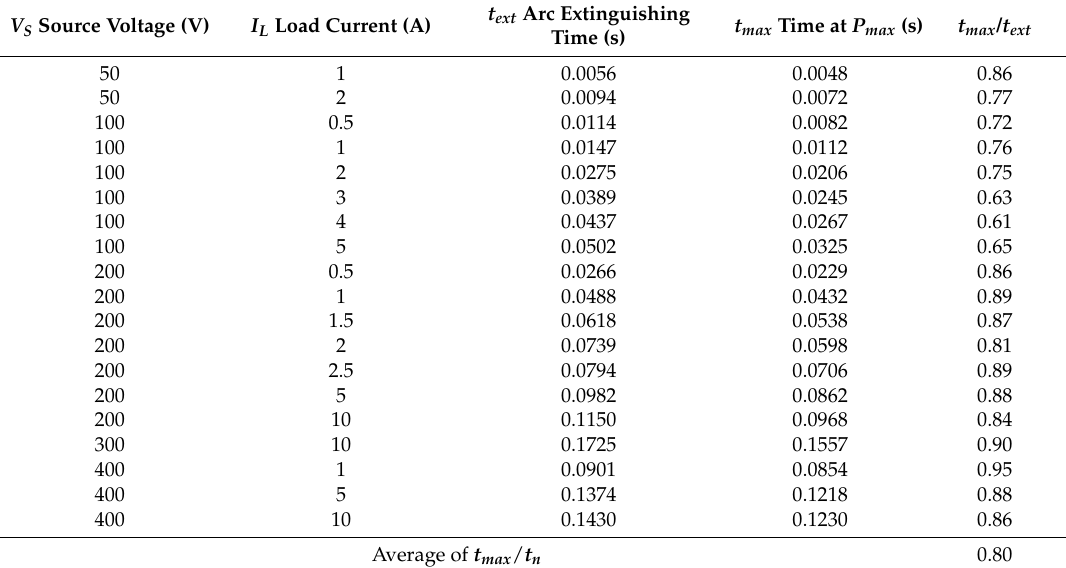
Table 4. t max (time at maximum arc power) at P max (maximum arc power) and t ext (arc extinguishing time)